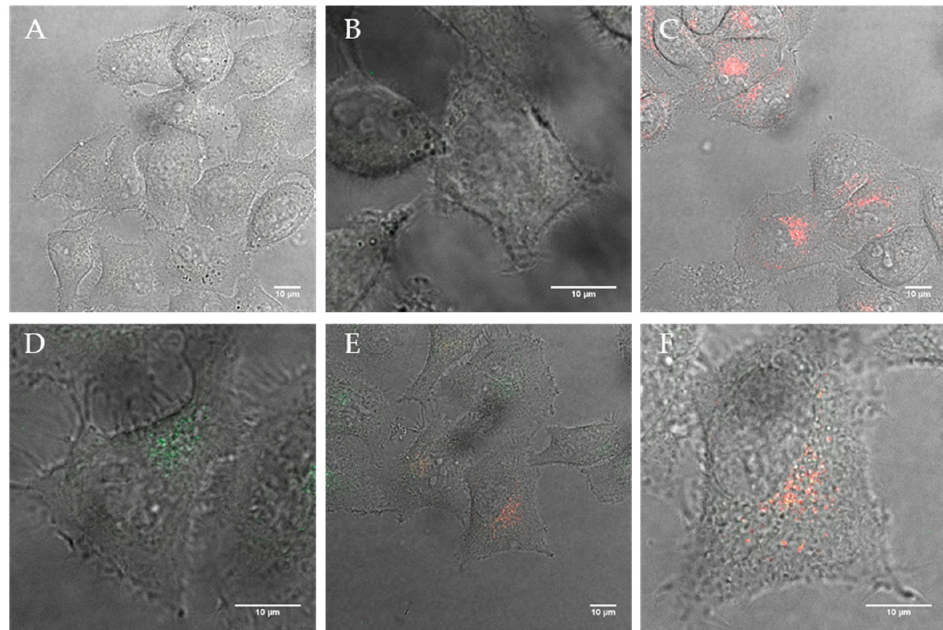
Figure 2. Confocal images of ( A ) HeLa cells (negative control), ( B ) HeLa cells after 12 h incubation with PBD(1200)- b -PEO(600) polymersomes (1% DEAC labeled), ( C ) HeLa cells after 12 h incubation with cell light stain expression a red fluorescent protein (RFP) in lysosomes, ( D ) HeLa cells after 12 h incubation with neutrally charged but polycation coated PBD(1200)- b -PEO(600)-COOH/ b -PEI(800) polymersomes (positive control), ( E + F ) co-localization of the fluorescently labeled cationically coated polymersomes (green) within lysosomes (red). Unmodified polymersomes exhibit negligible uptake while those modified with cationic b -PEI show increased frequency of internalization and localization within lysosomes.